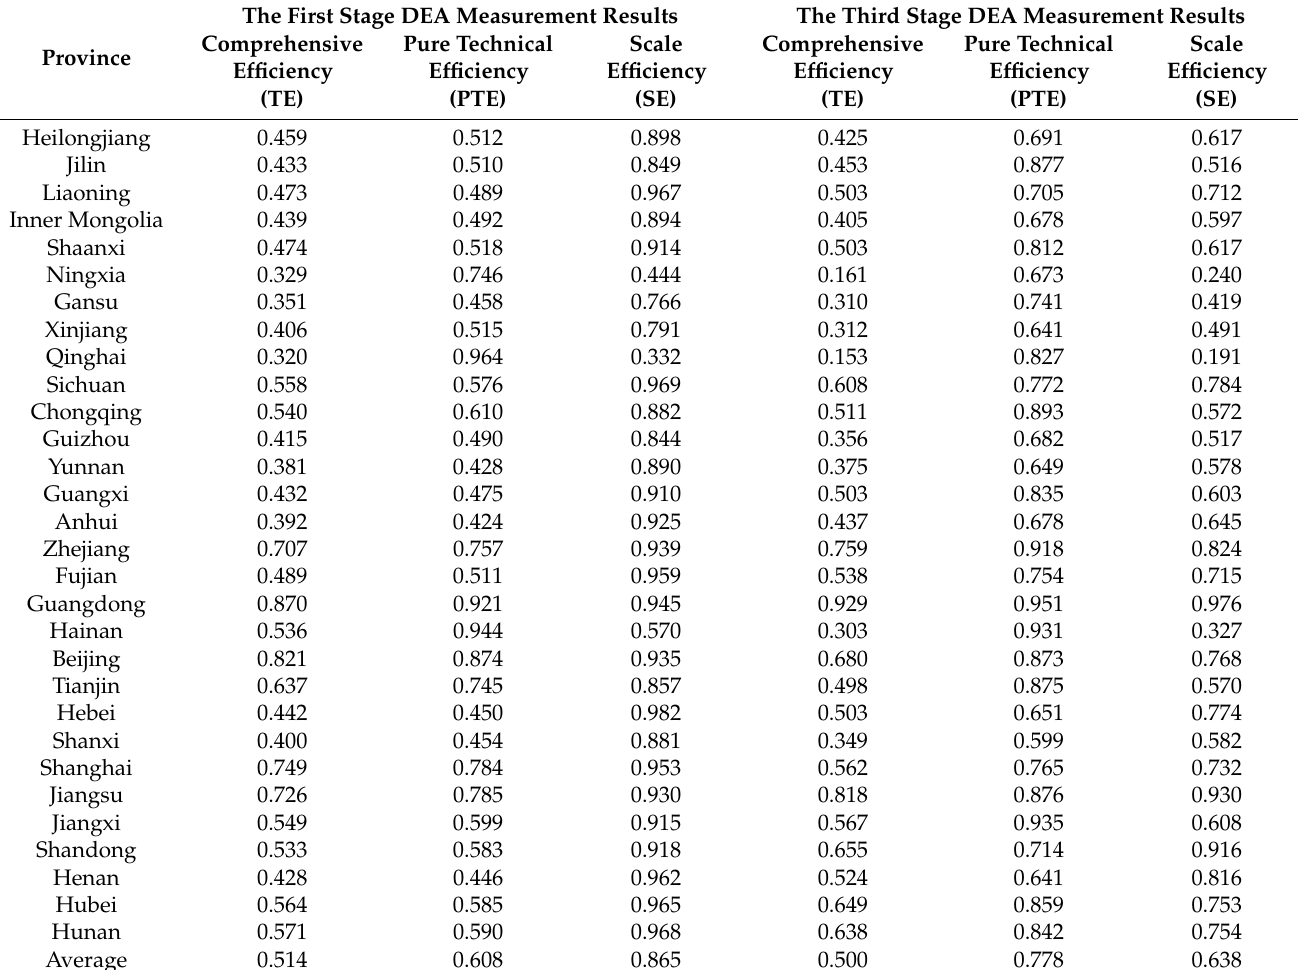
Table 4. Carbon emission efficiency during China’s first and third stages (2009–2018 annual average